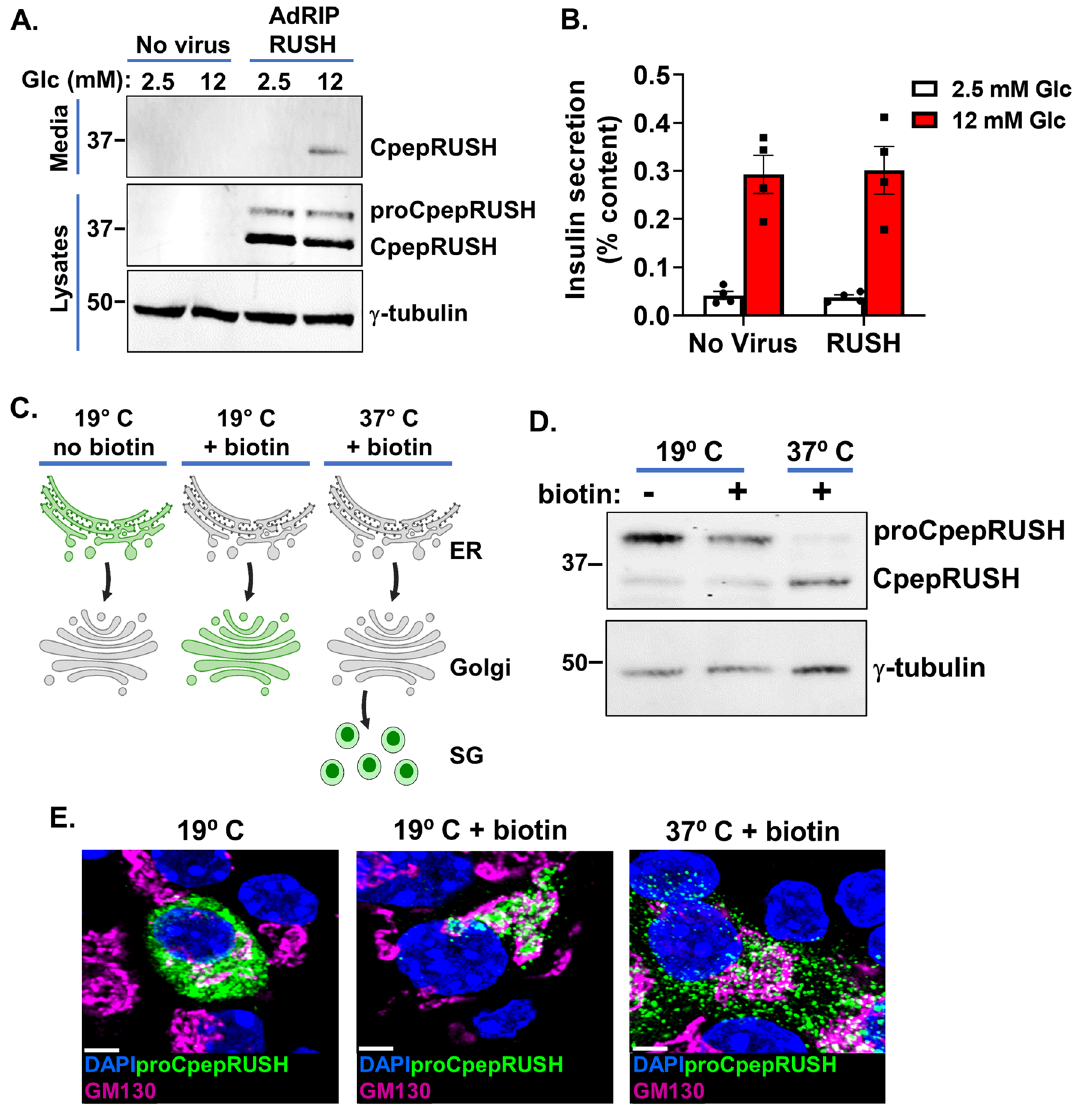
Figure 3. Processing and secretion of proCpepRUSH. ( A ) INS1 832/3 cells treated with AdRIP-proCpepRUSH or no virus (control) were supplemented with biotin (200 μM) for 3 h. Glucose-stimulated insulin secretion was measured by static incubation in media containing 2.5 mM Glc or 12 mM Glc for 3 h each. TCA precipitated media was analyzed by immunoblot and compared to whole cell lysate. ( B ) Primary mouse islets (C57BL6/J) treated with AdRIP-proCpepRUSH or no virus were analyzed for glucose-stimulated insulin secretion via sequential static incubation in media containing 2.5 mM and 12 mM glucose for 1 h each as indicated. Data are normalized to insulin content determined from cell lysates. Data represents the mean ± S.E.M. ( C ) Schematic demonstrating the use of biotin treatment in conjunction with temperature block to examine ER, Golgi, and secretory granule localization of proCpepRUSH. This model was created using biorender.com. ( D , E ) Isolated mouse islets were treated with AdRIP-proCpepRUSH. 48 h post-infection, islets were incubated at 19 °C for 1 h (ER retained), then treated with biotin (200 μM) for an additional 2 h at 19 °C to initiate proCpepRUSH (green) trafficking, but prevent Golgi exit. Islets were then shifted to 37 °C for 2 h to stimulate Golgi release. ( D ) Whole cell lysates were analyzed by immunoblot using anti-GFP to detect proCpepRUSH and CpepRUSH. ( E ) Cells were immunostained for GM130 (magenta) and counterstained with DAPI (blue). Scale bar = 5